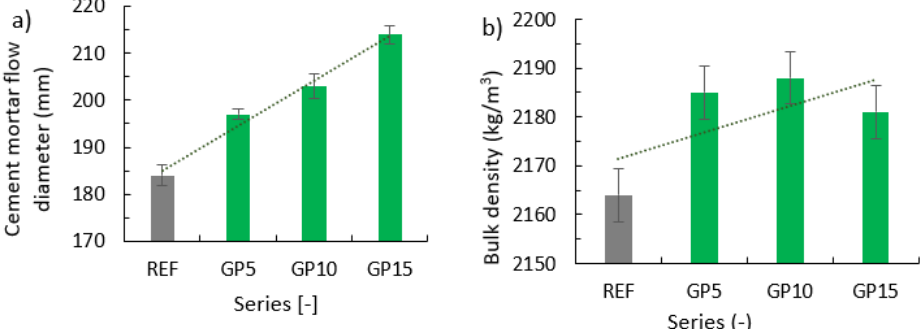
Figure 2. Properties of the fresh cement mortars with a partial replacement of cement with the gran- ite powder: ( a ) cement mortar flow diameter; ( b ) bulk density. powder: ( a ) cement mortar flow diameter; ( b ) bulk